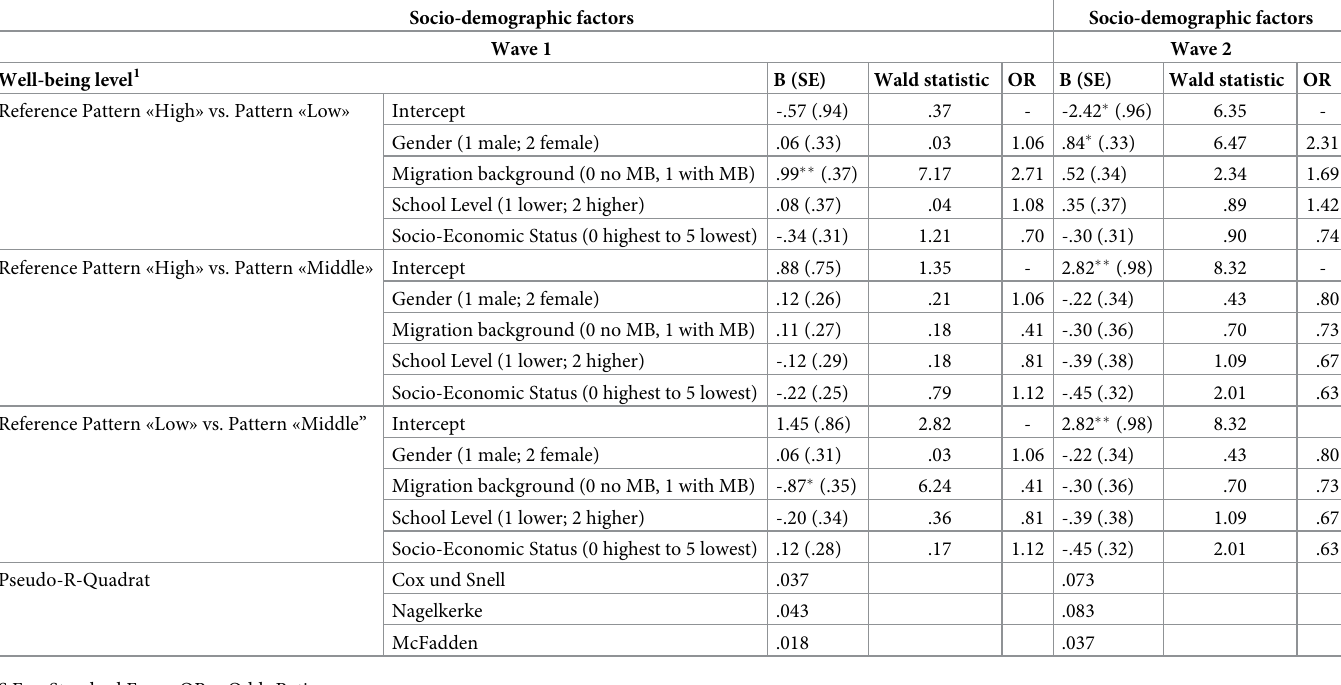
Table 6. Wave 1& 2, multinomial logistic regression of socio-demographic covariates, resilience, and depression/anxiety to the identified latent status membership: Parameter estimates of both models. Socio-demographic factors Socio-demographic factors Wave 1 Wave